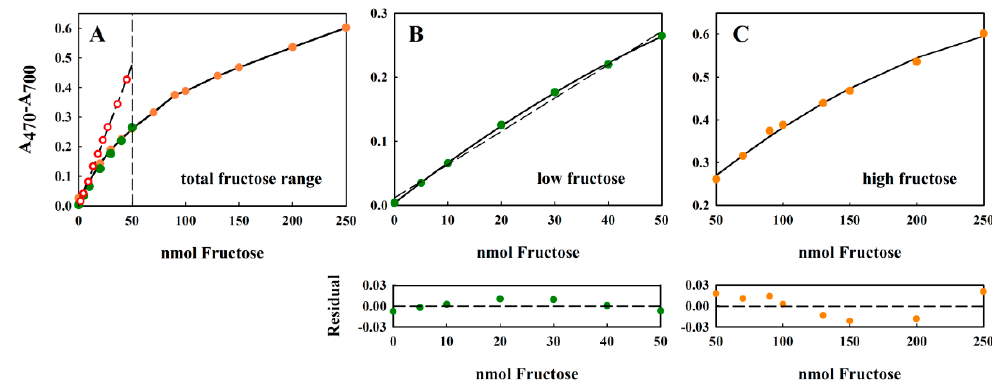
Figure 3. Standard curve of fructose showing good overlap between the absorption values measured with the 2.5 mM and 10 mM stock solutions. All measurements were performed in triplicate, and the average value is indicated. The error of the measurement was usually about 2% (data not shown). The separated ranges, indicated by the dashed line in panel ( A ) 0–50 nmol fructose and 50–250 nmol fructose, have been extracted from ( A ) and plotted separately in panels ( B , C ), respectively. For the data in both panels B and C, the solid lines correspond to a polynomial regression to the equation y = y o + ax + bx 2 , whereas the dashed line shown in panel B corresponds to a linear regression to the equation: y = y o + ax. For the 0–50 nmol fructose data set, the polynomial constants were: y o = 0.0033 ± 0.0013; a = 0.0066 ± 0.0001; b = − 2.728 × 10 –5 ± 2.67 × 10 − 6 . For the linear fit to the same data, the fitted constants were: y o = 0.0114 ± 0.0047; a = 0.0052 ± 0.0002. For the 50–250 nmol fructose data set, the polynomial constants were: y o = 0.0629 ± 0.136; a = 0.004 ± 0.0004; and b = − 7.71 × 10 − 6 ± 2.73 × 10 − 8 . The quality of the fit has been shown using the residual plot (lower panels under ( B , C )), defined as {(A 470 –A 700 ) exptl − (A 470 –A 700 ) calc }, where (A 470 − A 700 ) calc has been calculated from the fitted equation. For the 0–50 nmol fructose range, only the residual derived from the linear fit is shown. In panel ( A ), the original Kulka data [10], recalculated to include the four-fold dilution in our assay, is also shown (red circles, dashed line).